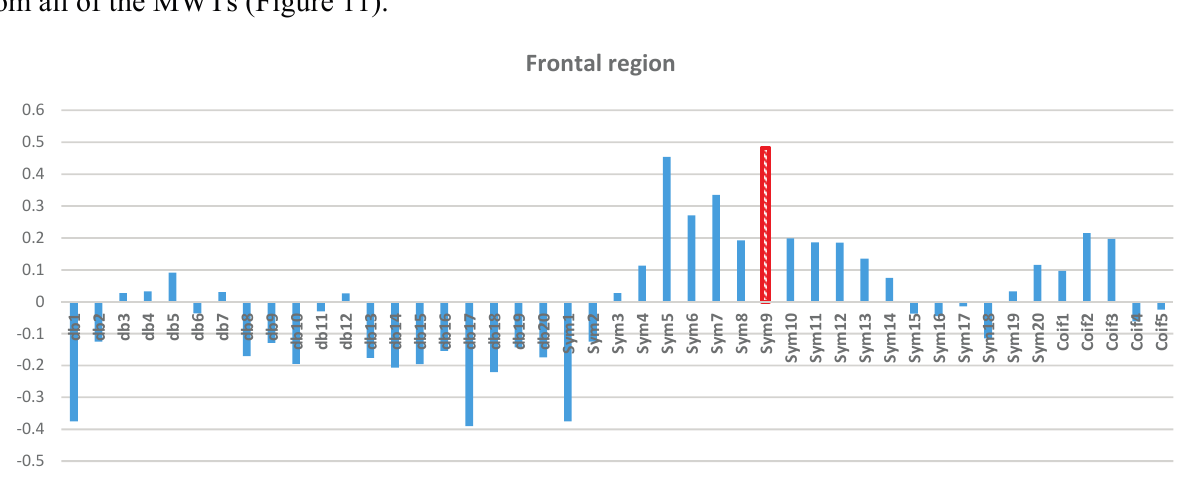
Figure 7. Comparative plot of correlation coefficients with 45 mother wavelet filter for the frontal region of the brain for 10 control subjects.